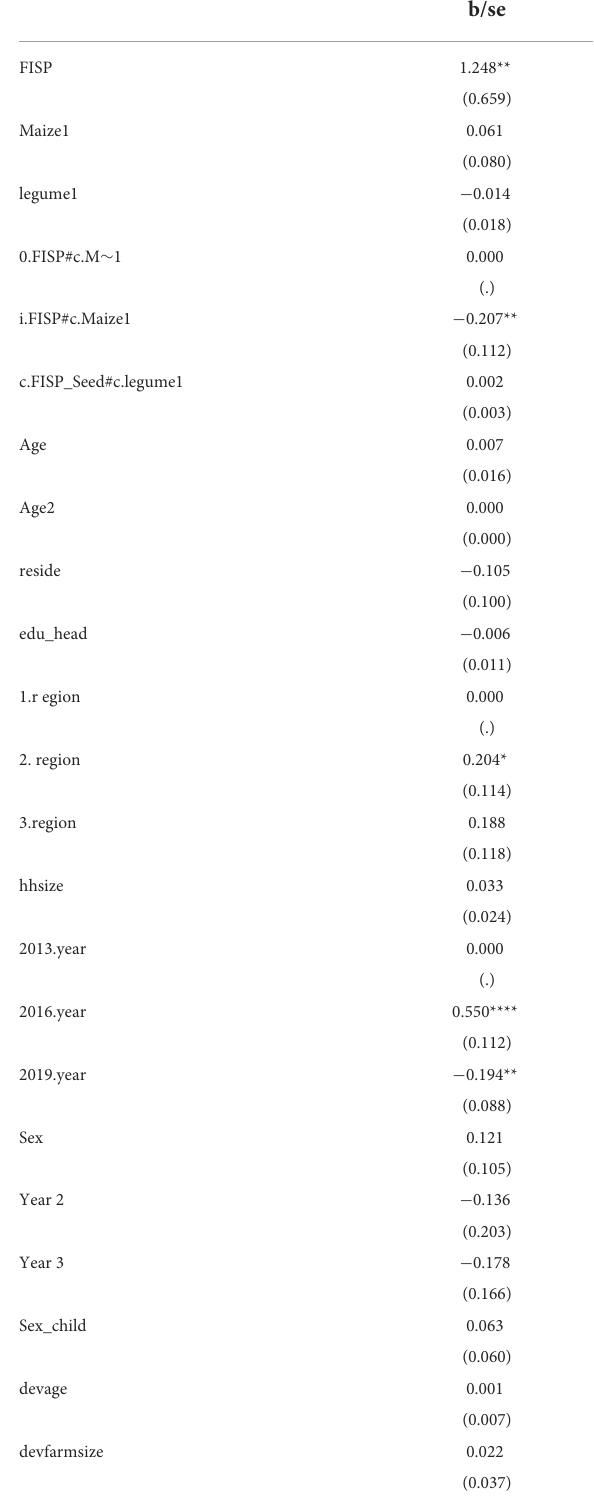
TABLE 5 Results of impact of FISP on wasting among children under-5